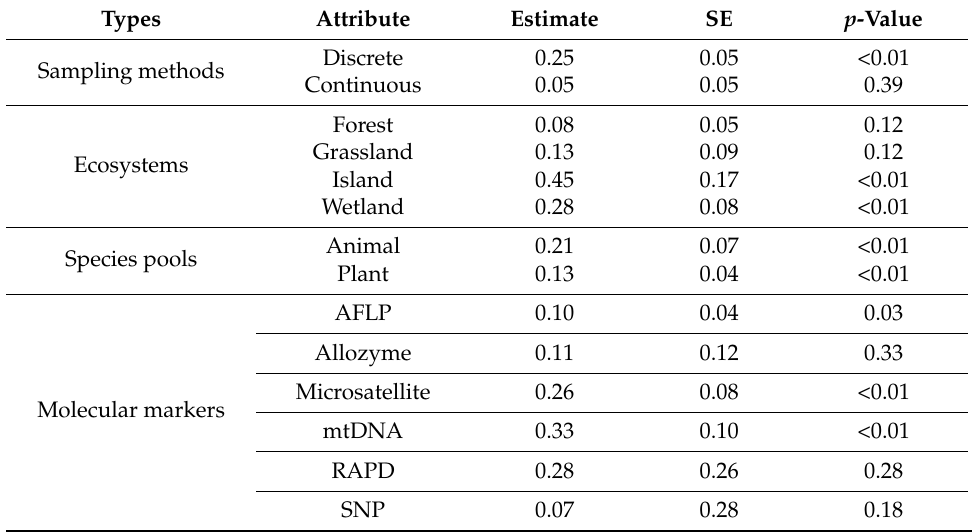
Figure 4. Effects of continuous variables on SGDC. ( a ) MAT: mean annual temperature, ( b ) MAP: mean annual precipitation, ( c ) N: number of sampling units. Partial linear regressions were used to fit the blue lines and the 95% CIs are presented as shaded areas. The significance ( p -value) is shown for the tested relationship. The sizes of the circles represent the weights of the observations. Table 1. Effects of categorical variables (sampling methods, ecosystems, species pools, and molecular markers) on effect size of SGDC.